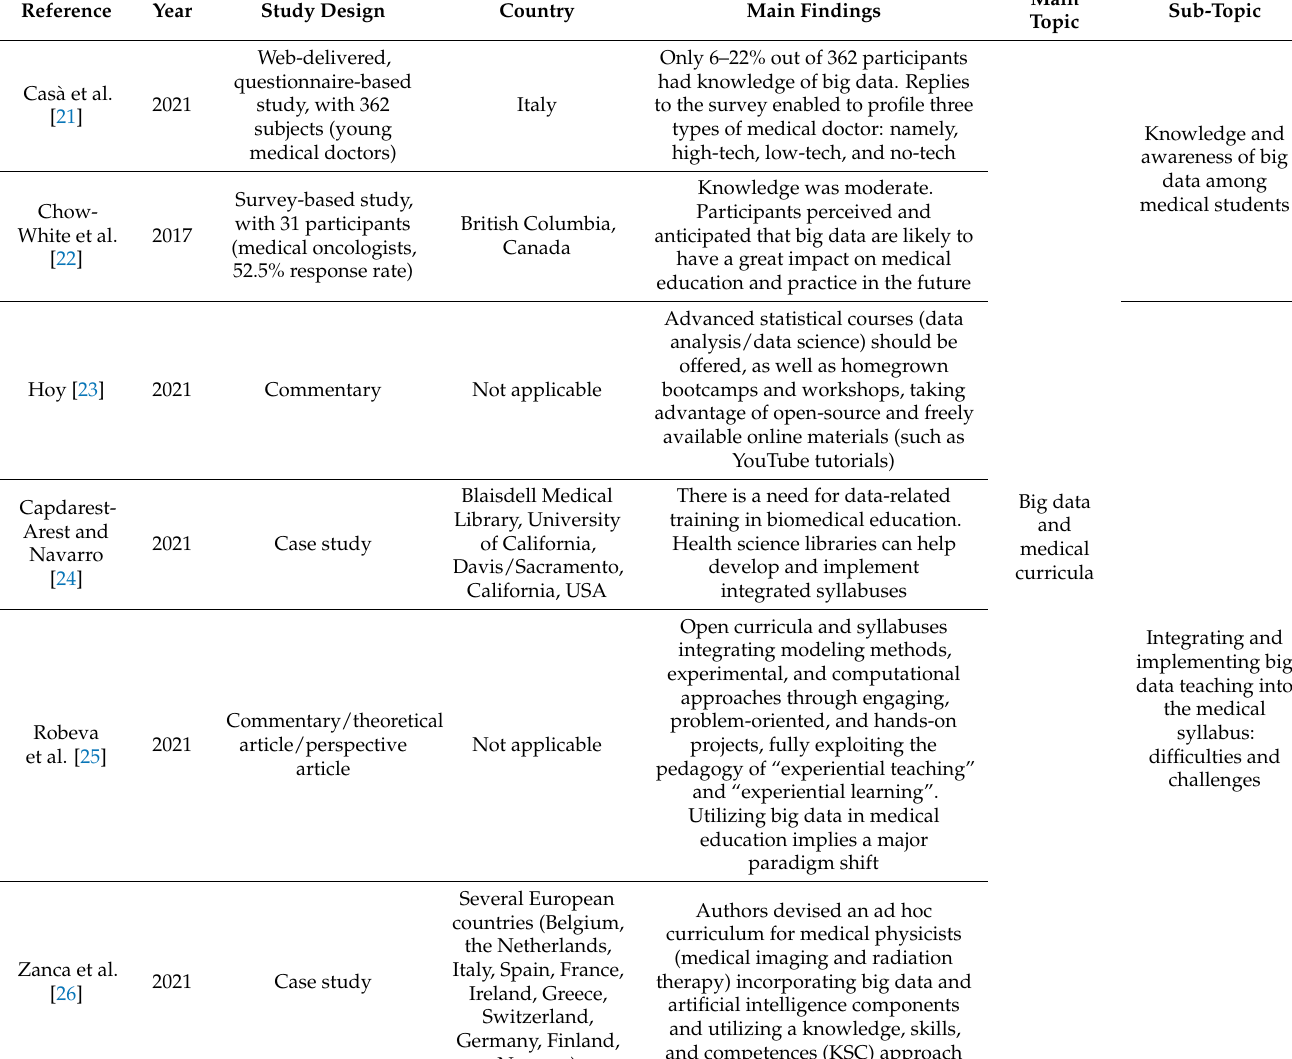
Table 1. Main characteristics of the studies included in the present integrative review of the literature. Reference Study Design Country Main